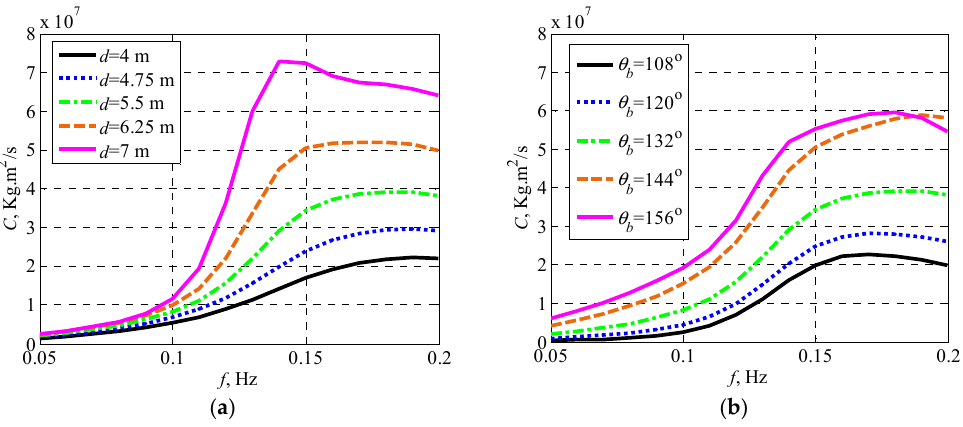
Figure 7. Radiation damping coefficient as a function of wave frequency at different floating states: ( a ) for fixed beak angle at θ b = 144°; and ( b ) for fixed depth of rotation axis at d = 5.5 m.